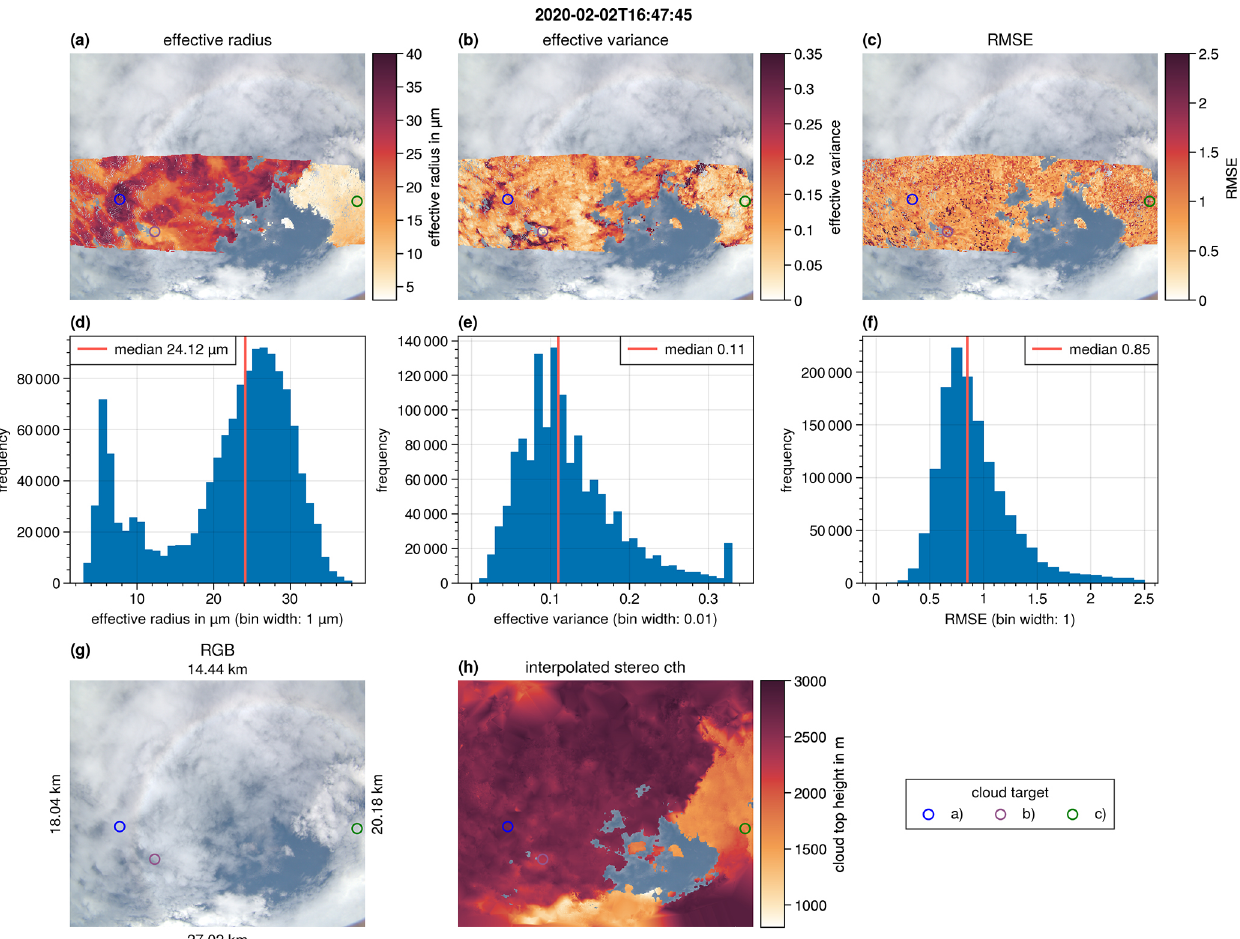
Figure 7. Spatial distributions of r eff (a) , v eff (b) , and RMSE (c) for the case study presented in Fig. 2. Panels (d) – (f) show the corresponding frequency distributions. Panel (g) shows the RGB image of the measurement. The labels on the four sides of the RGB image indicate the distances between neighboring corners of the image. Panel (h) shows the cloud top height from the stereo method interpolated onto the whole pixel grid of the image. Three specific cloud targets are indicated by colored circles on the